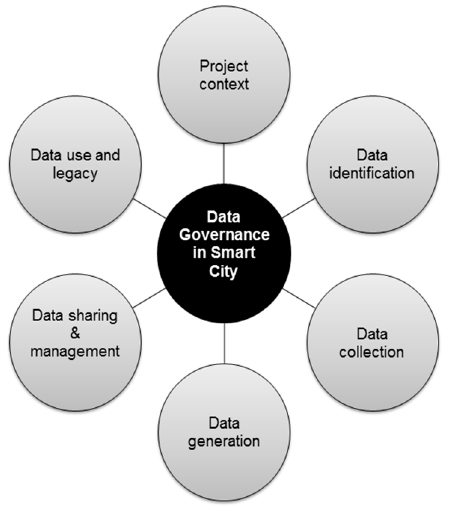
Figure 2. Key pillars of data governance in smart city initiatives.